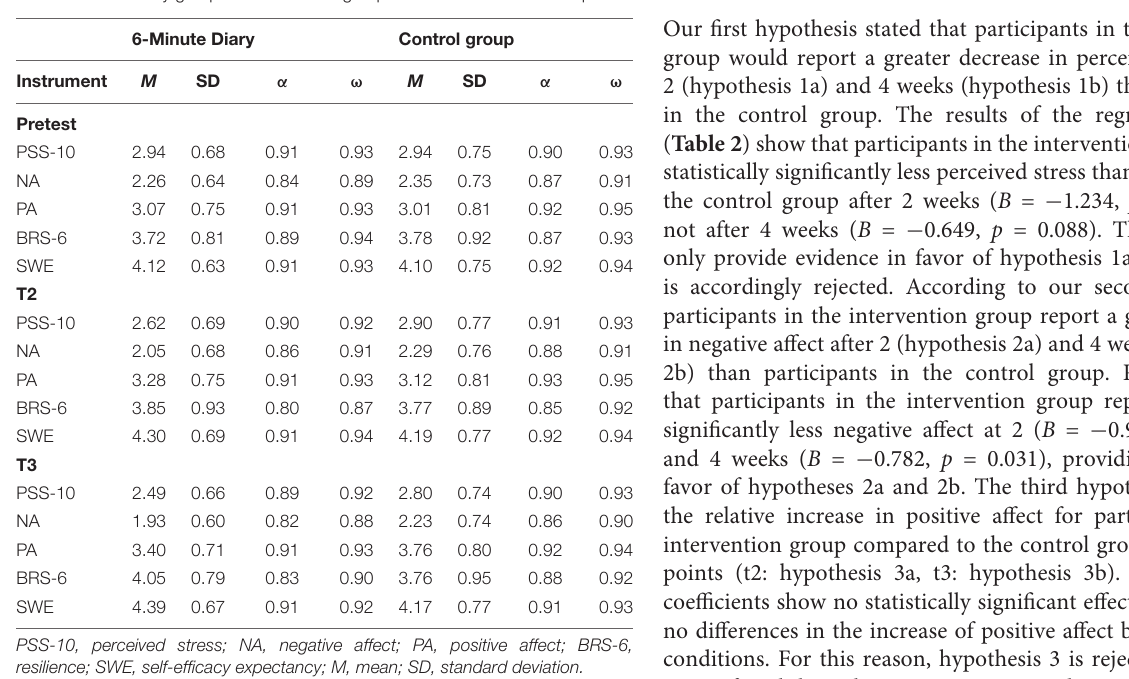
TABLE 1 | Means, standard deviations, Cronbach’s alpha, and McDonalds omega in the 6-minute diary group and the control group at all three measurement points.